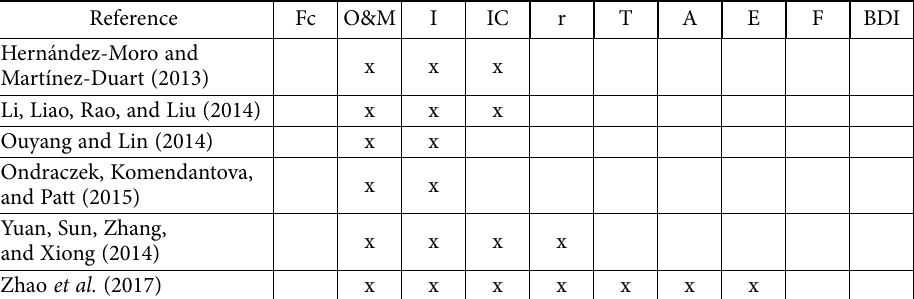
Table 5. Factors considered in the analysis of LCOE: empirical evidence